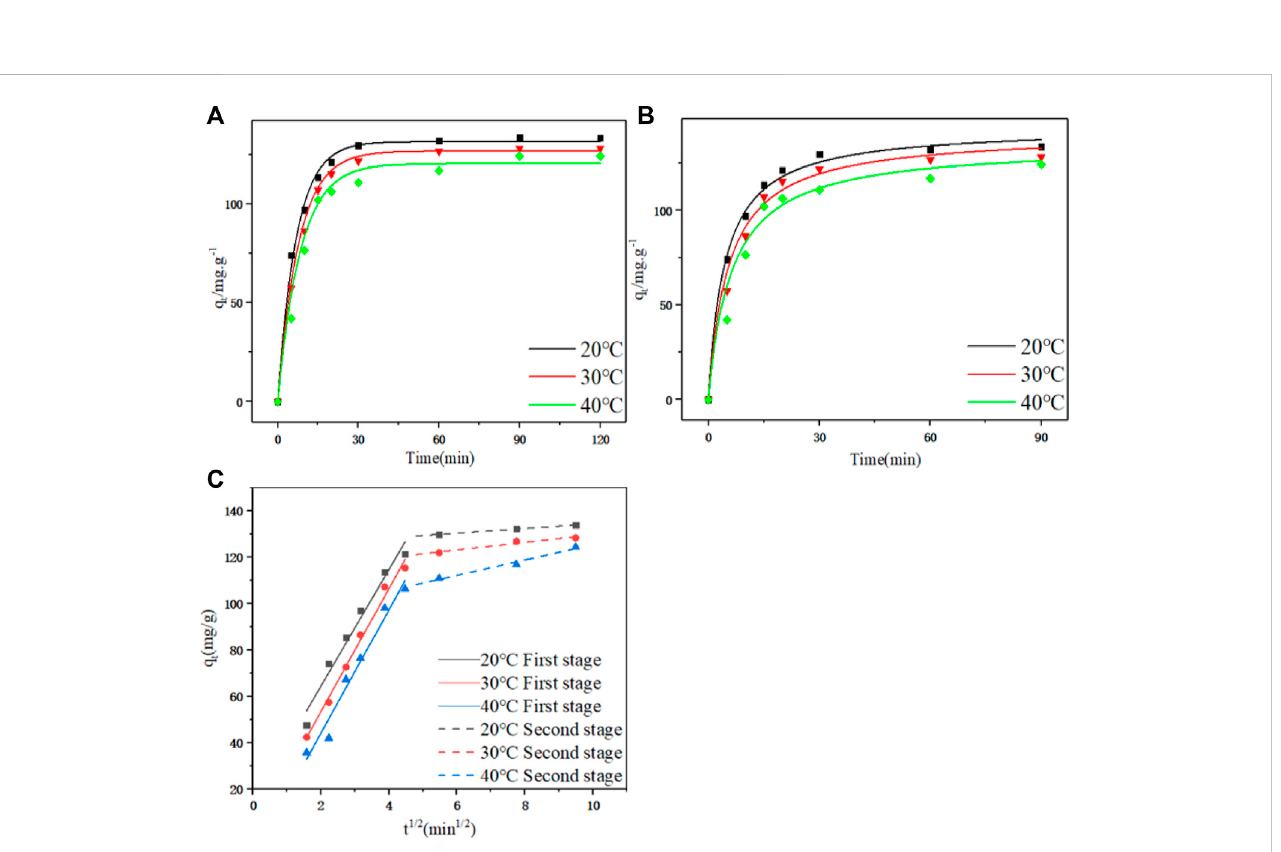
FIGURE 4 (A) Pseudo fi rst-order kinetic curves at different temperatures. (B) Pseudo second-order and pseudo fi rst-order dynamic curves at different temperatures. (C) Linear fi tting diagram of particle diffusion at different